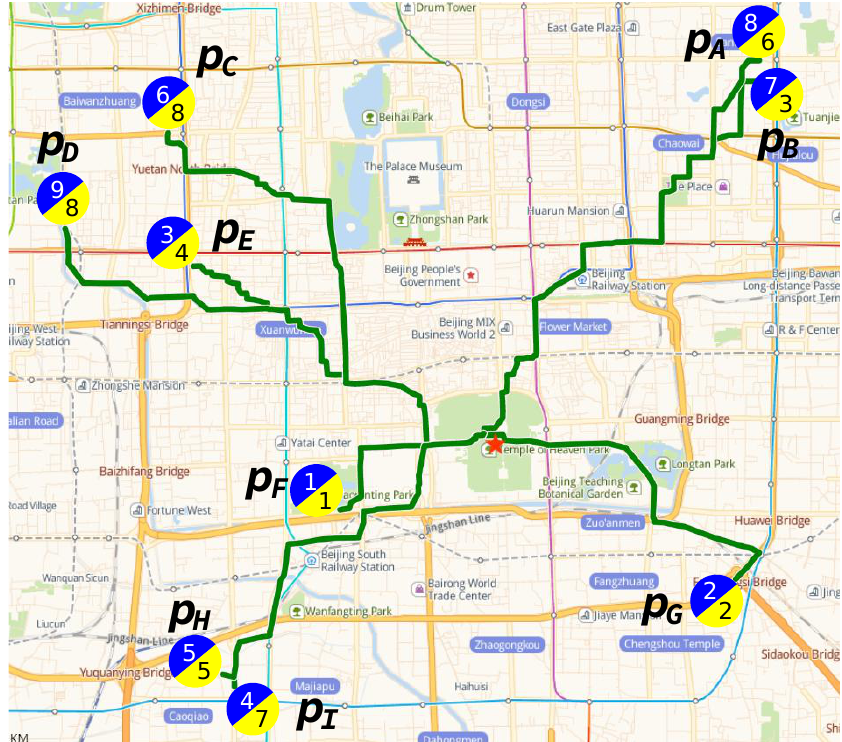
Figure 5. Demonstration of vehicle evacuation sequence based on route diversity (In case of Figure 1, the numbers in the blue and yellow semicircles indicate the evacuation order in the spatial diversity- based and route diversity-based algorithms